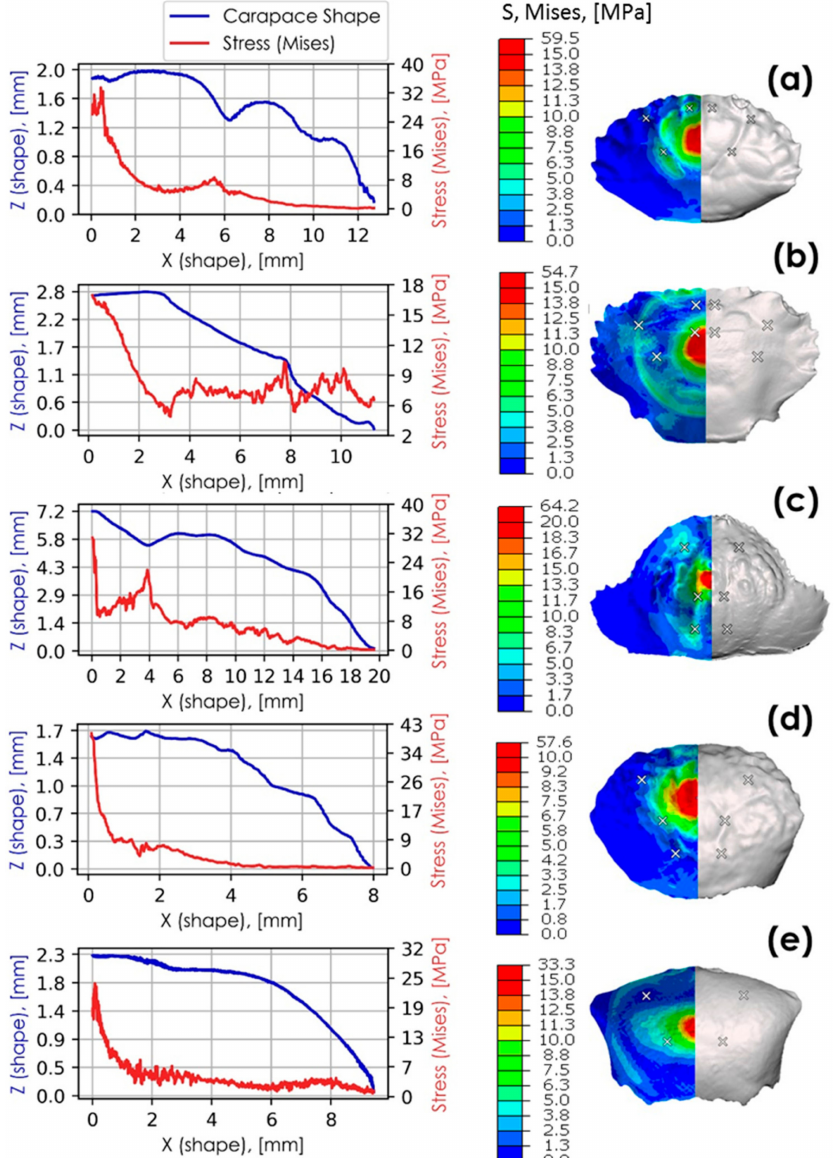
Figure 12. Stress (von Mises) plotted against carapace surface profiles where Z coordinates are shown in blue and stress in red. These are shown alongside surface stress profiles (von Mises) for: ( a ) L. sanguineus (anterior view); ( b ) Thalamita sp. (side view); ( c ) C . hepatica (anterior view); ( d ) P . vespertilio (anterior view); ( e ) U. tetragonon (anterior view). Carapace groove minima are identified by white